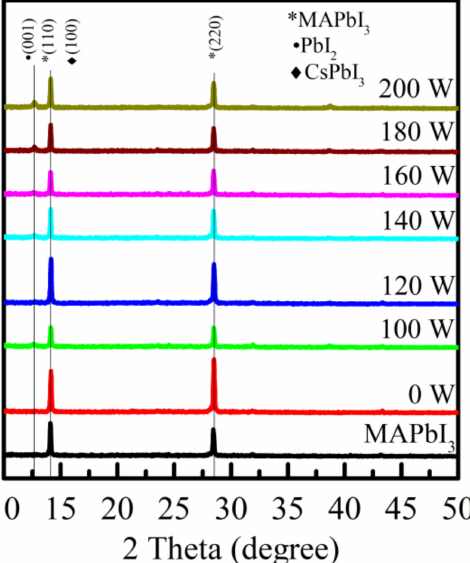
Figure 5. XRD patterns of MAPbI 3 and composite perovskite film treated by argon plasma at different